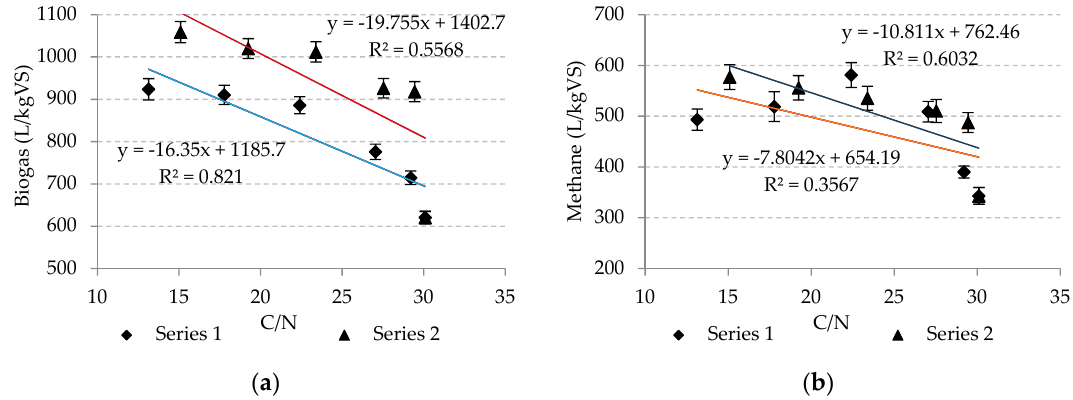
Figure 2. Correlation between the C/N ratio and biogas ( a ) and methane ( b ) production.